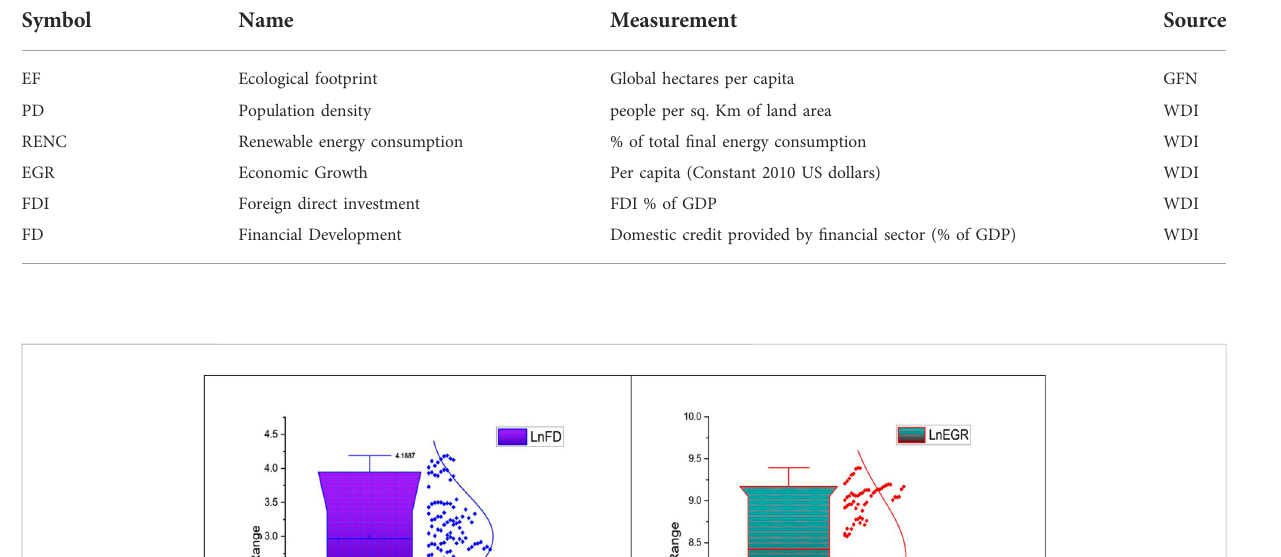
TABLE 1 Data source and measurement.